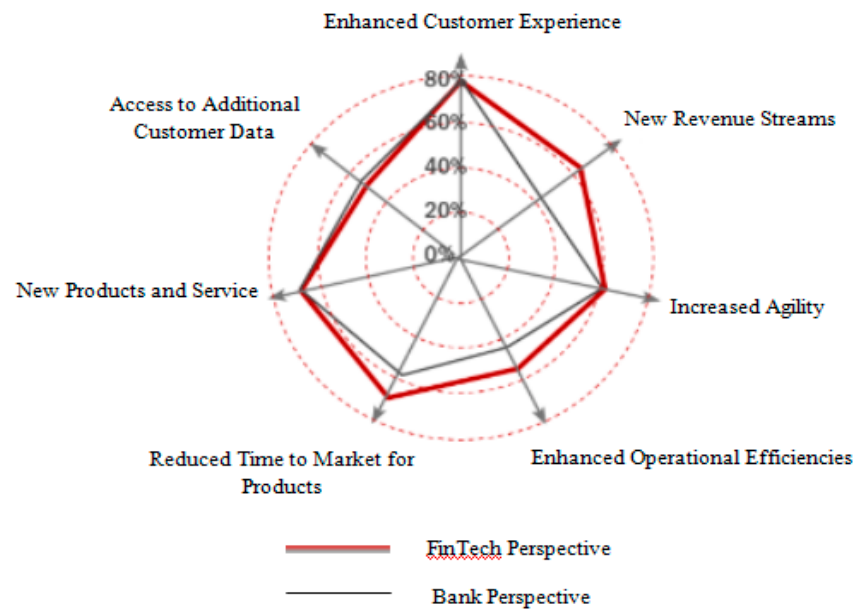
Figure 12. Benefits of implementing banks’ APIs. Source: Capgemini (2017b) Retail Banking Executive Interview Survey, Capgemini Global Financial Service.